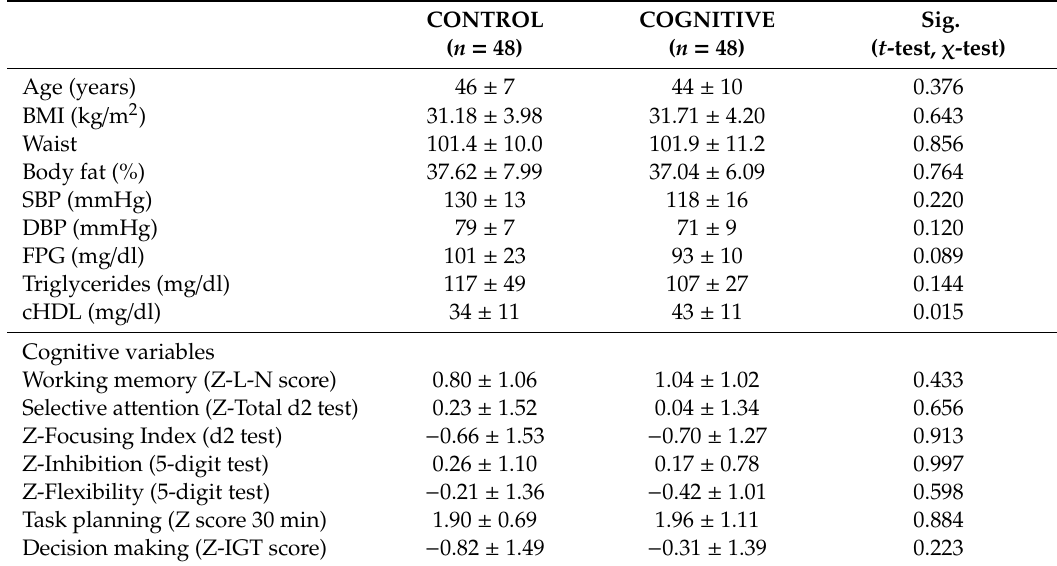
Table 1. Baseline participant clinical, anthropometrical and cognitive characteristics.